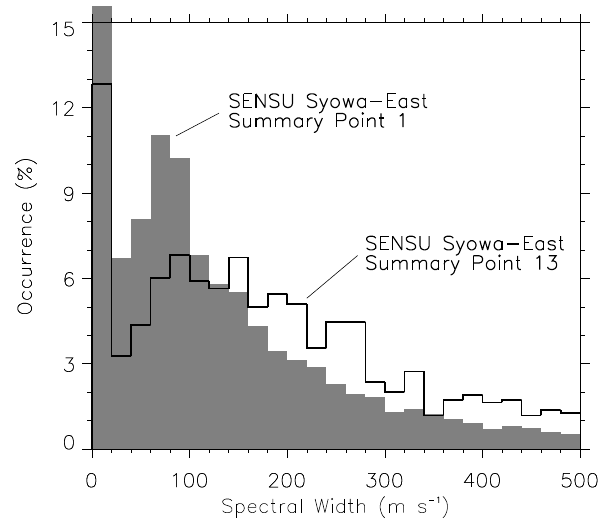
Fig. 7. The histogram of the spectral width distribution at S1 (shaded) and S13 (black line) in